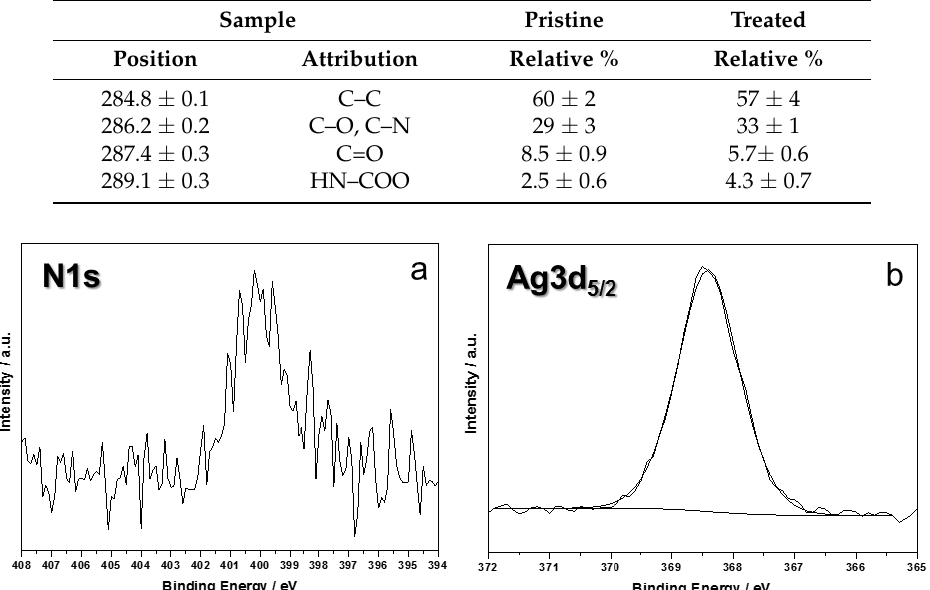
Table 2. Leather C1s signal components. Error is expressed as the larger value between the error associated to a single quantification and one standard deviation, calculated on at least three replicate analyses.